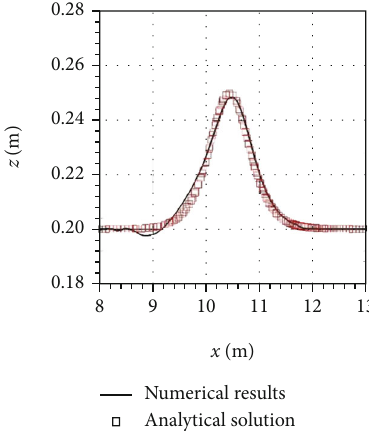
Figure 3: Comparison between the numerical and analytical free surface pro fi les at the centerline of the computational domain for H / h = 0 : 25 .